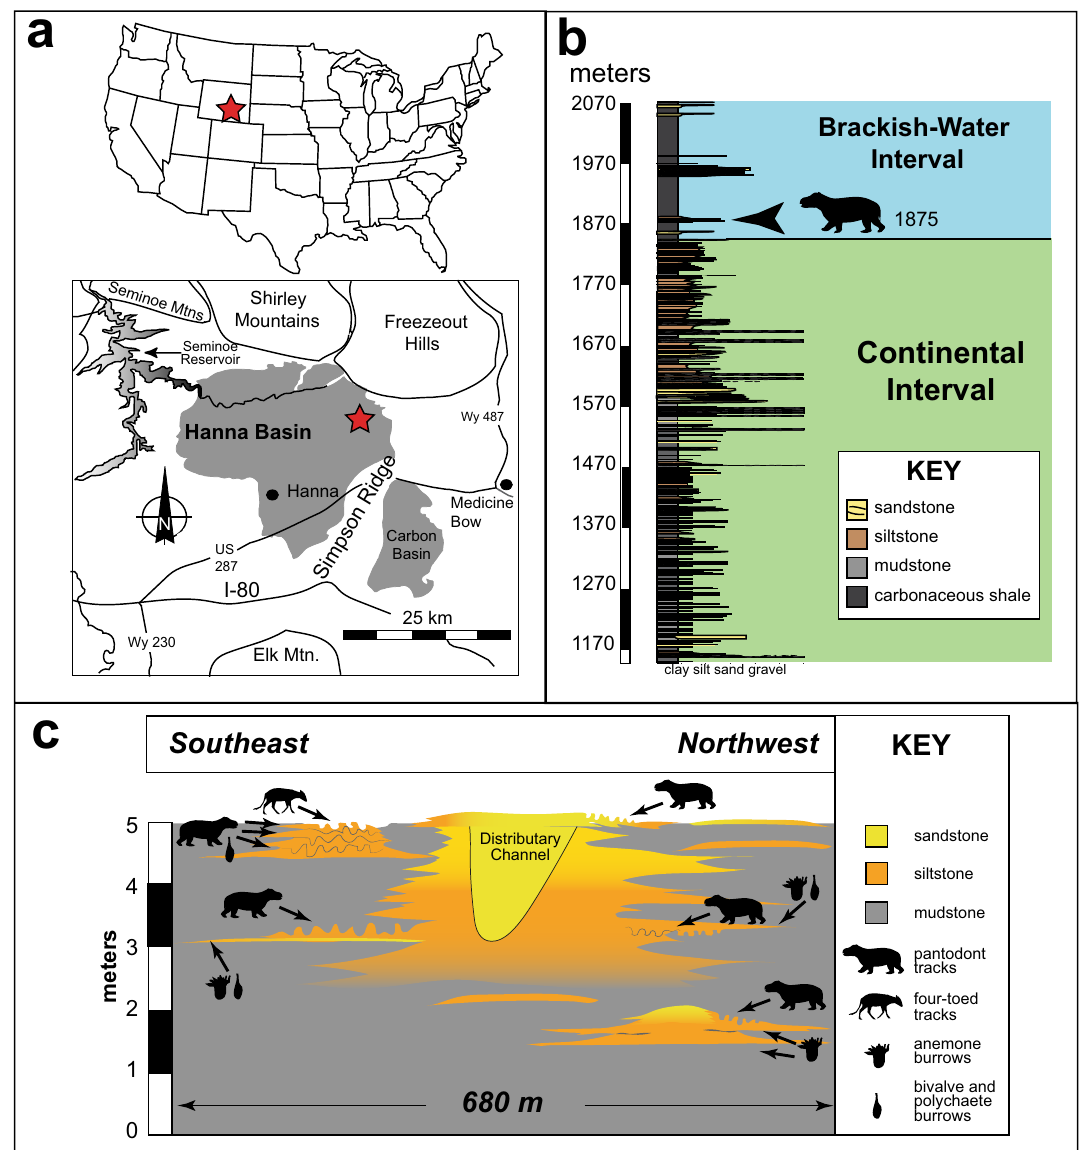
Figure 1. ( a ) Location and stratigraphic setting of the tracksite; ( b ) Measured section is stratigraphic elevation above local base of the Hanna Formation. Entire succession falls within P5 palynostratigraphic zone, with tracksite in the uppermost portion of the zone; ( c ) Stratigraphic and aerial distribution of mammal prints and other significant trace fossils within the main section of the tracksite. Drawings and maps made by A F-J W in Adobe Illustrator 2021 (version 25.2.1, https:// www. adobe. com/ produ cts/ illus trator. html). Photographs by A F-J W and compiled in Microsoft PowerPoint (version 16.0.13801.20266, https:// www. micro soft. com/ en- us/ micro soft- 365/ power